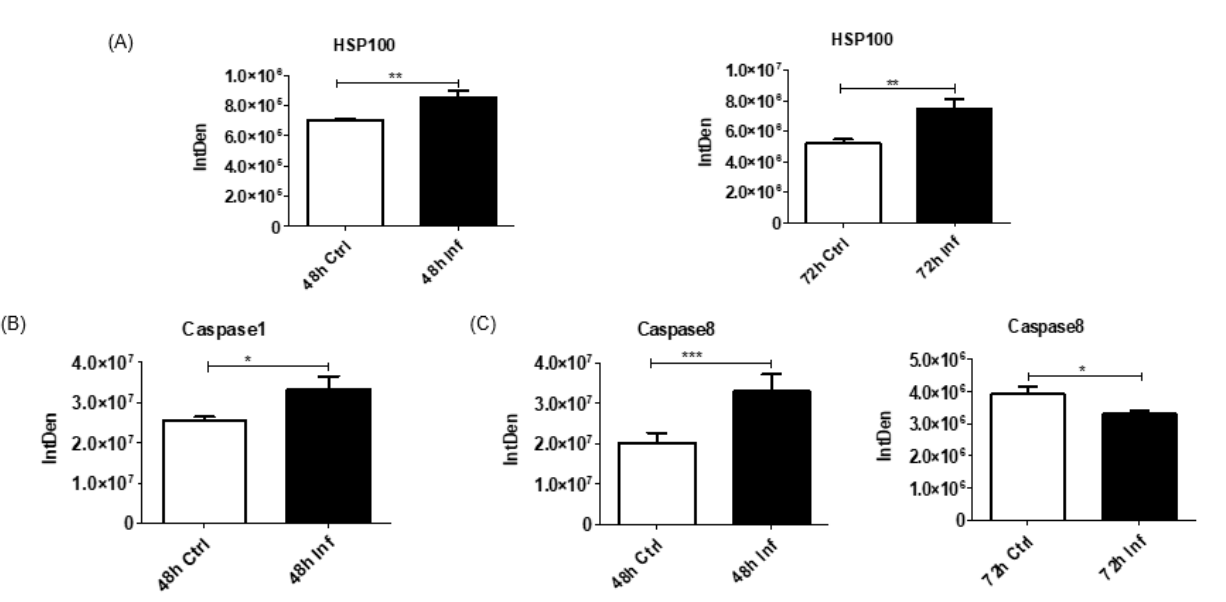
Figure 6. The effect of CCoV infection on heat shock protein and caspases. Graphs showing densitometric analysis of dot blot of ( A ) heat shock protein HSP100 (Supplementary Figure S2I) at 48 h and 72 h, ( B ) caspase-1 (Supplementary Figure S2J) level at 48 h, and ( C ) caspase-8 level (Supplementary Figure S2K) at 48 h and 72 h, in isolated control and infection-derived EVs. Statistical analysis of obtained data points was performed using one-way ANOVA with Tukey post hoc analysis. Statistical significance is indicated by the mean ± SD and is defined as p ≤ 0.05 (*), p ≤ 0.01 (**) and p ≤ 0.001